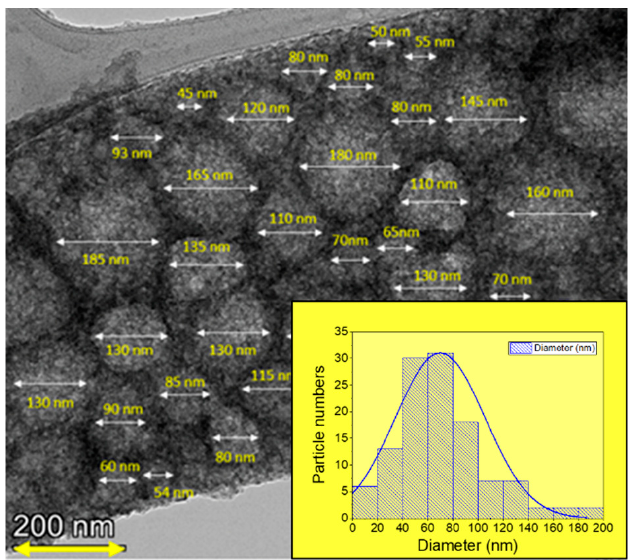
Figure 5. TEM micrograph of OMO(40) and the particle-size histogram .